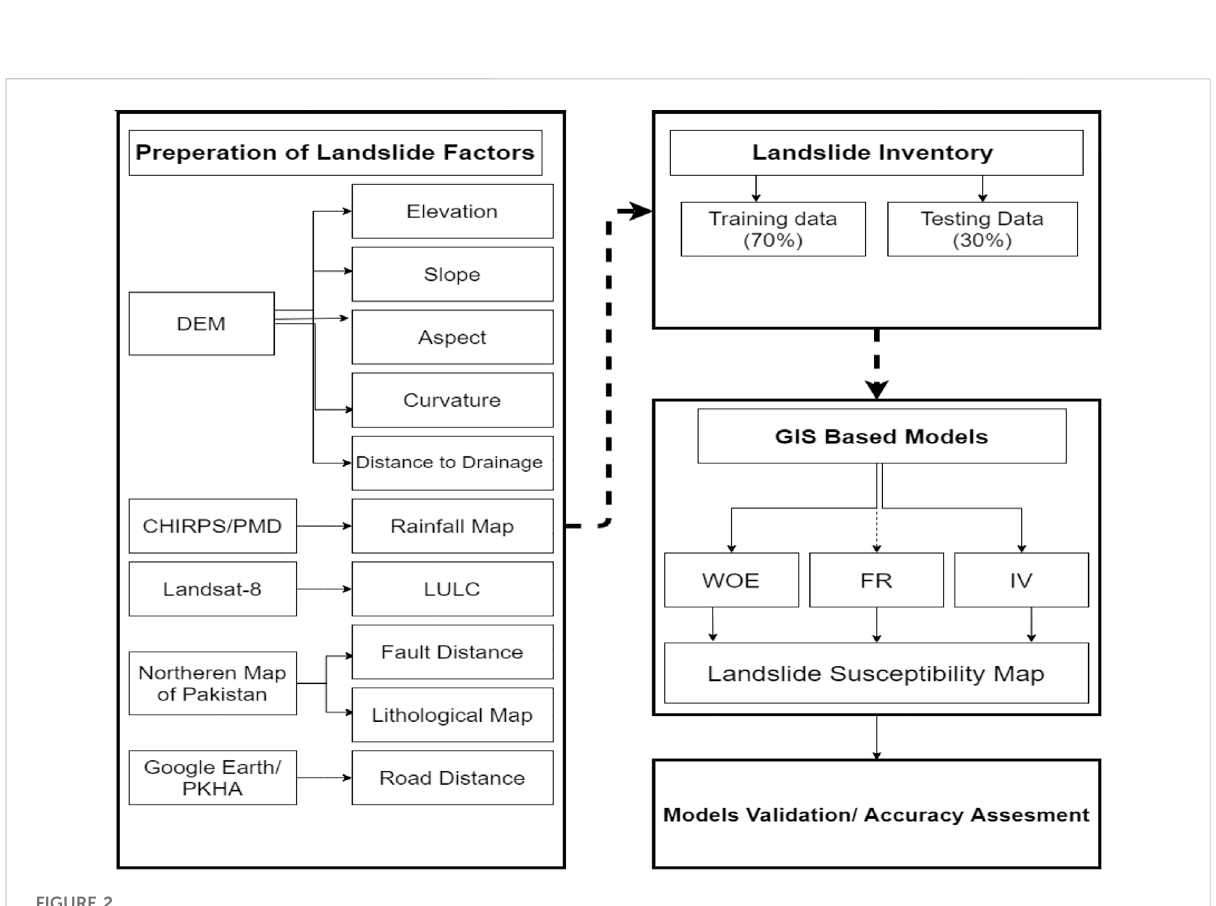
FIGURE 2 Methodology for GIS and RS-based landslide susceptibility